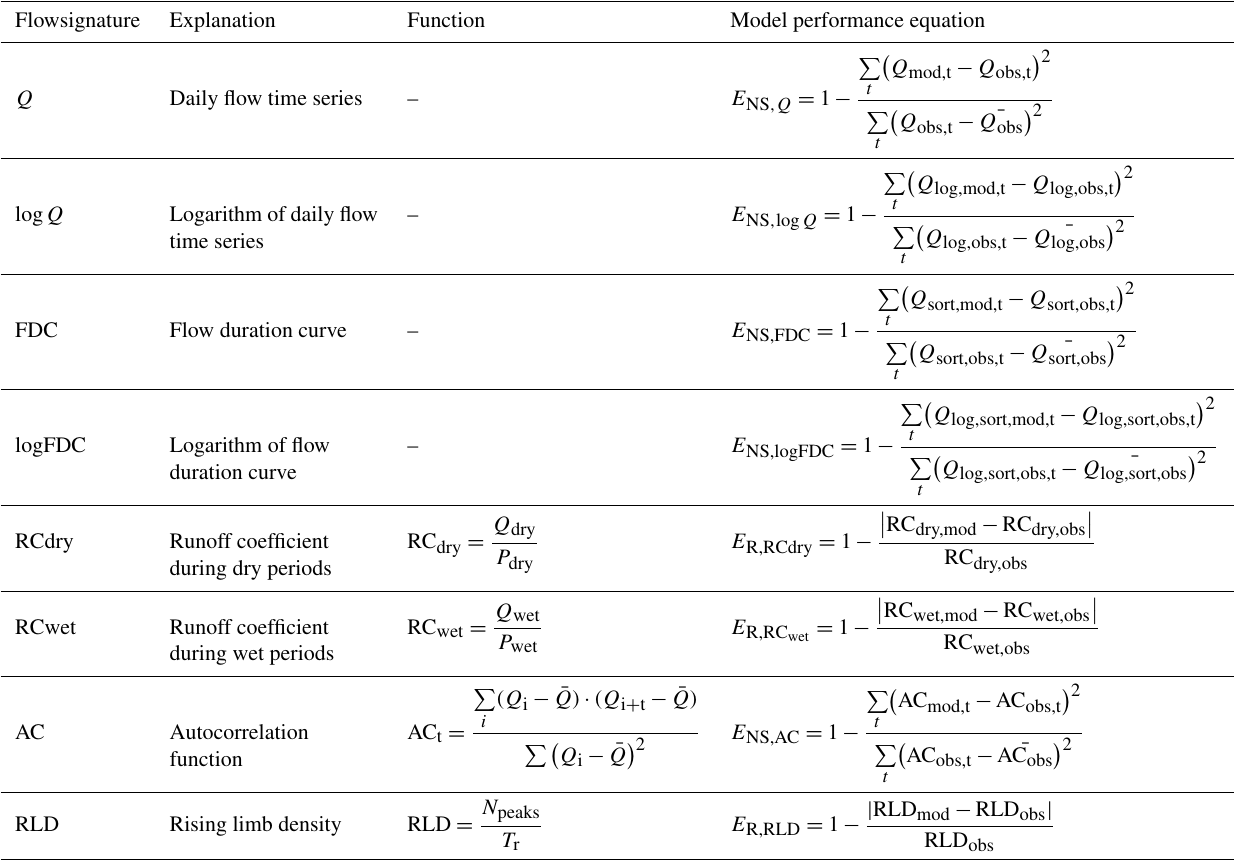
Table 6. Overview of flow signatures used in this study. Flowsignature